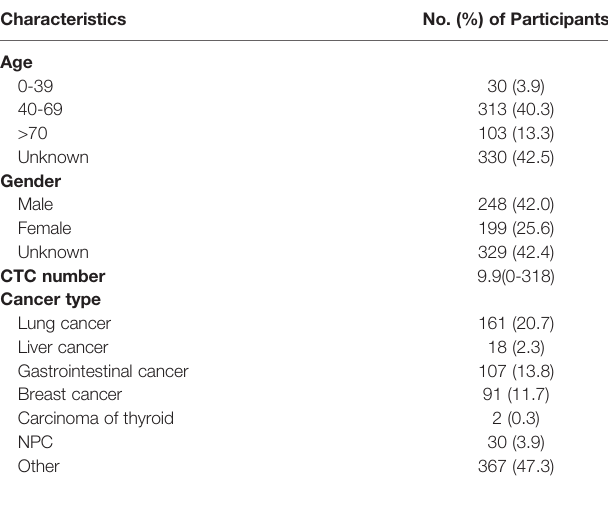
TABLE 1 | Summary of the general clinical information of patients. Characteristics